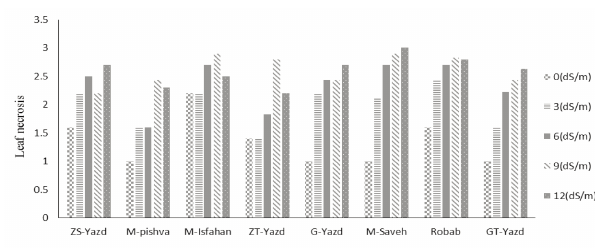
Fig. 5 ­ The interaction effects of salinity levels and cultivars on leaf